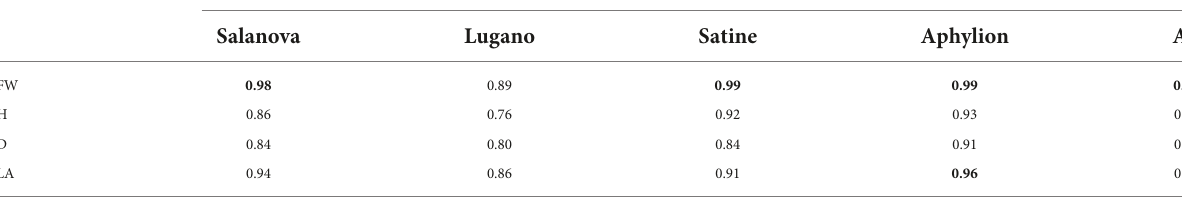
TABLE 2 Correlation between DW and other traits of different lettuce varieties. Traits